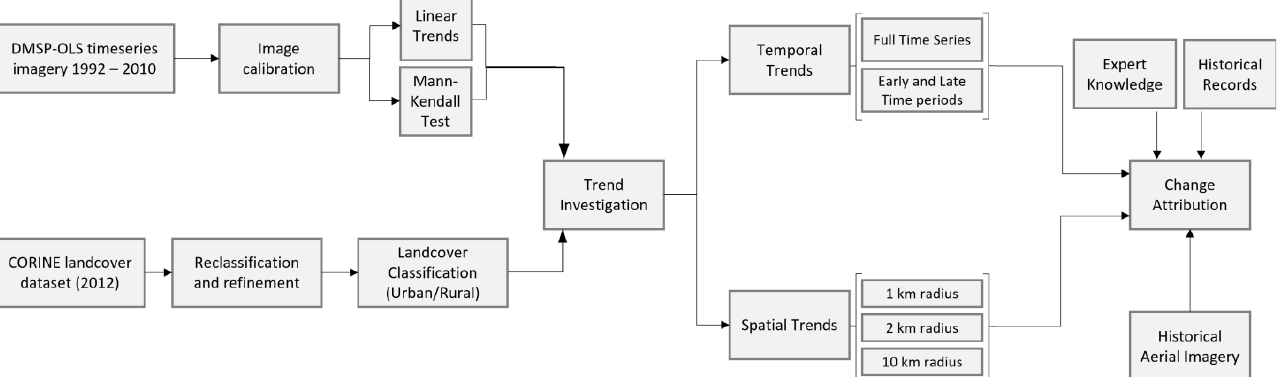
Figure 2. Methodological workflow for processing DMSP-OLS data, analyzing pixel-level trends using linear regressions and the Mann–Kendall test, and refining the CORINE dataset to reflect urban and rural land cover. Combining the trend analyses with the urban/rural land cover classes served as the basis for investigating temporal and spatial trends at various scales. Further integrating aerial imagery, expert knowledge, and historical records provided a framework for attributing local changes in nightlight intensity to specific landscape features.